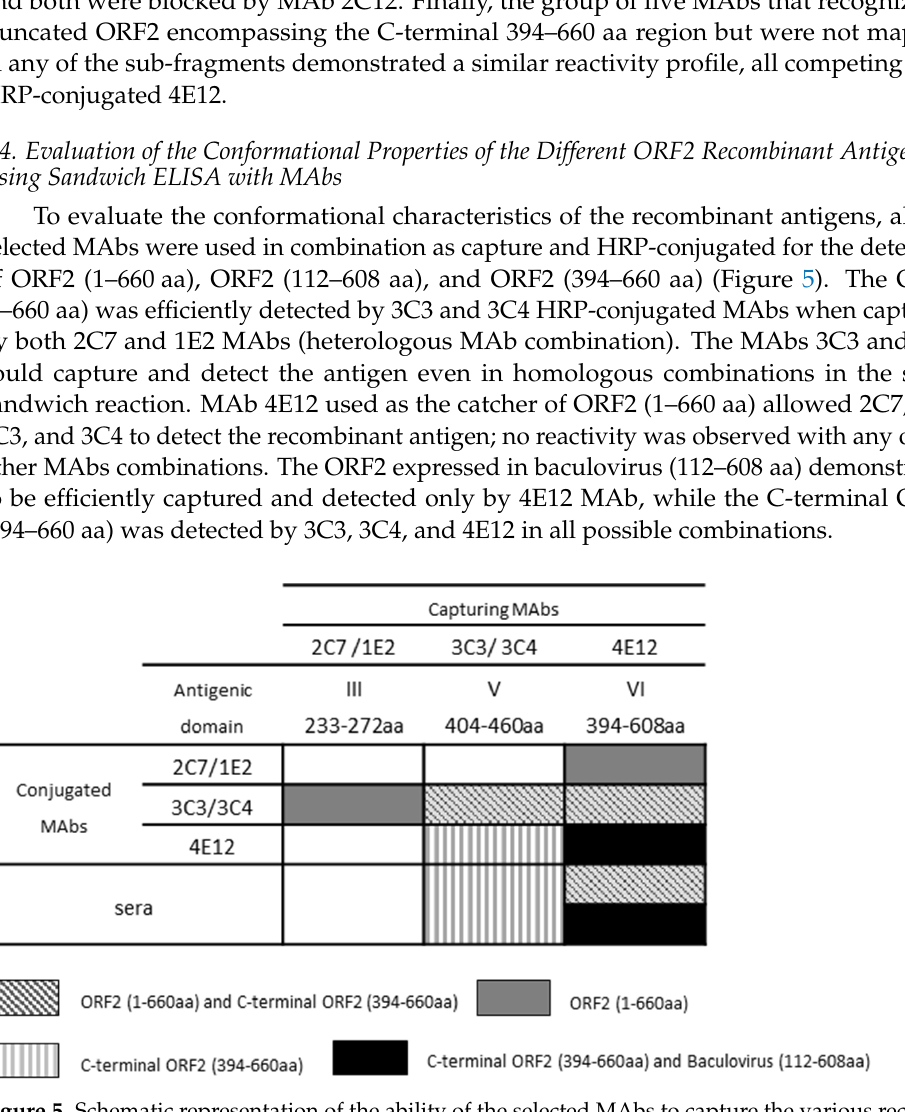
Figure 5. Schematic representation of the ability of the selected MAbs to capture the various recombinant proteins and expose them to the recognition of conjugated MAbs or four HEV-positive swine sera from experimental infection in sandwich and trapping ELISA, respectively.